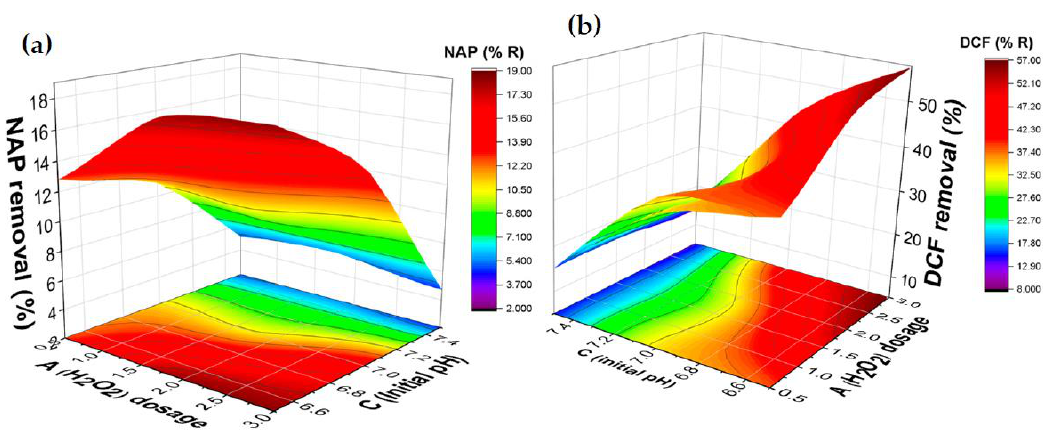
Figure 4. Combined effect of H 2 O 2 and pH on the removal of ( a ) NAP and ( b ) DCF. Reaction conditions: [NAP] 0 = [DCF] 0 = 5.0 mg L −1 , [catalyst] = 1.0 g L −1 , and 3 h of reaction time.